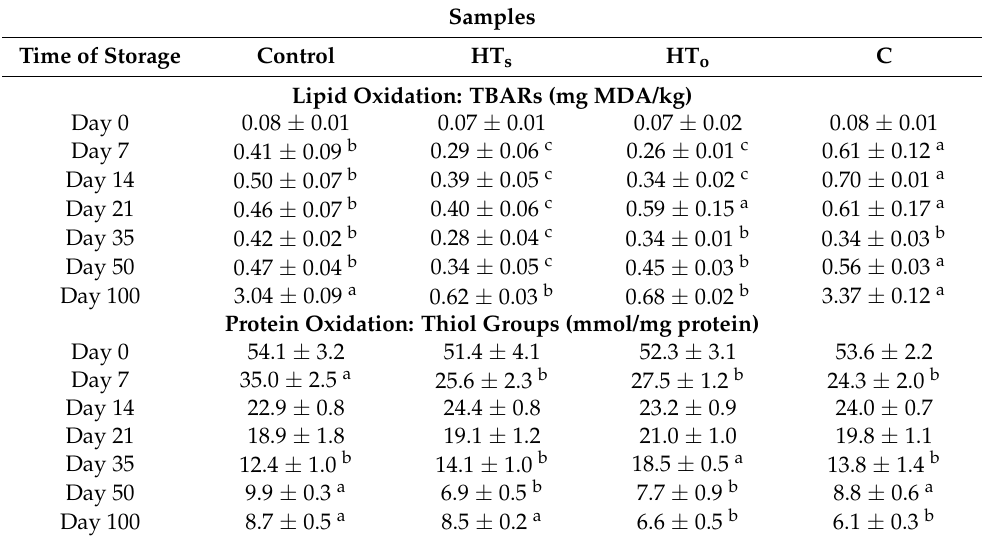
Table 5. Evolution lipid and protein oxidation of fuet samples for hundred days of shelf-life